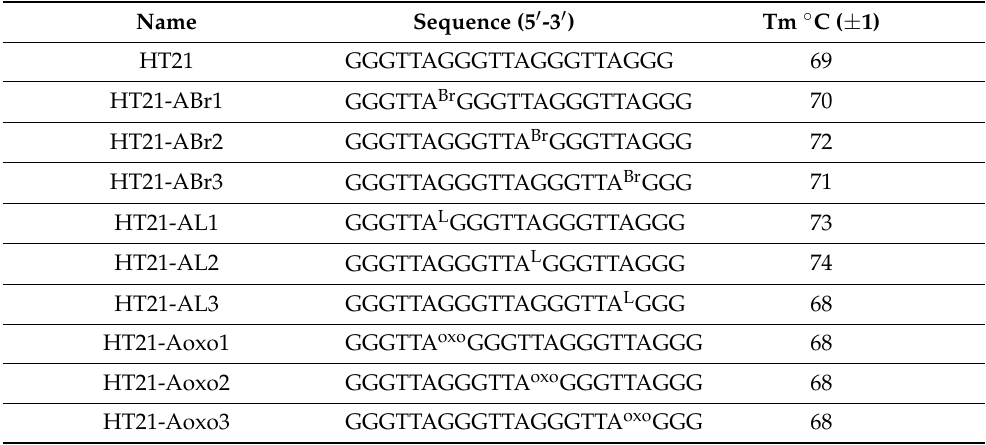
Table 1. Sequences investigated and their melting